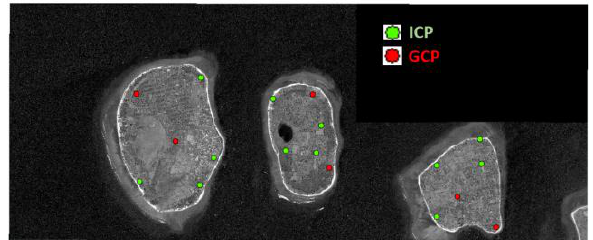
Figure 3. Distribution GCP and ICP over the satellite imagery